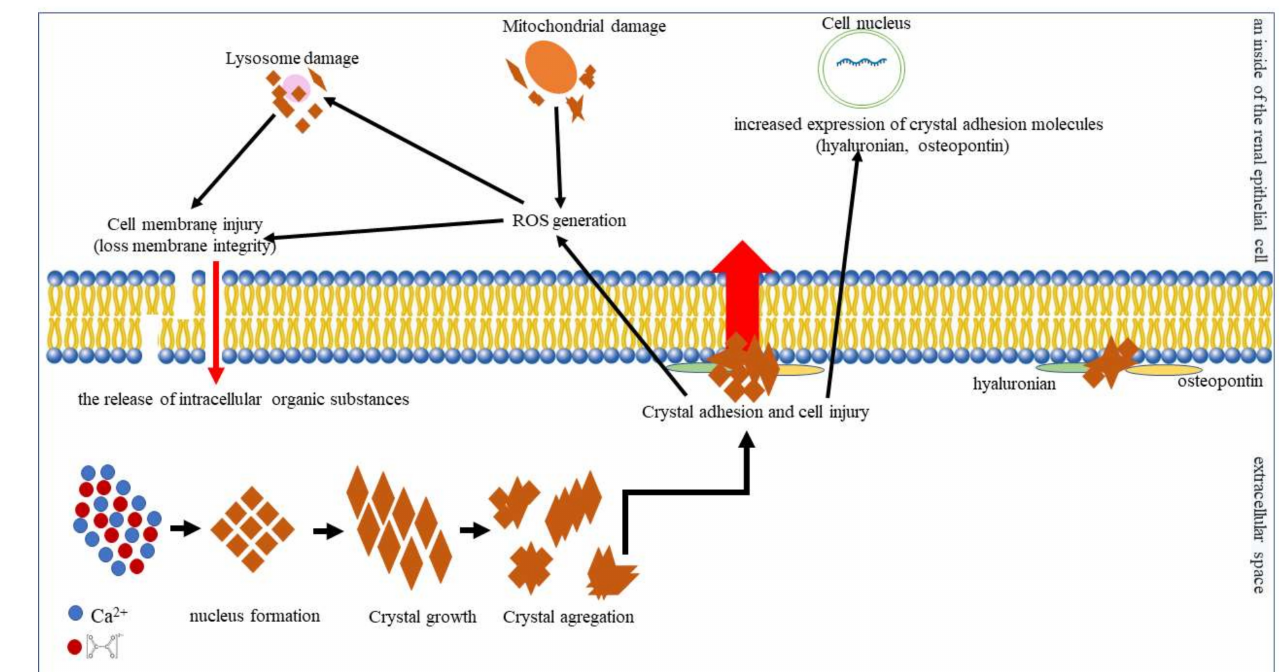
Figure 1. In supersaturated urine, calcium and oxalate combine to form initially microscopic in- soluble crystals. This is the first stage of deposit formation (nucleus formation). Then, individual microcrystals combine into larger forms (crystal growth), which, in turn, can aggregate together to form large, stable deposits (crystal aggregation) [34,35]. In the next stage, the crystals interact with the cells of the renal tubular epithelium. Crystal–cell interaction causes the movement of crystals from the basolateral side of cells to the basal membrane [36]. Injured cells release substances such as the kidney fragment of prothrombin − 1 or other anionic proteins that induce crystal agglomeration [37]. Moreover, injured cells can invert their cell membrane, which is anionic to the urinary environment and acts as a place of crystal adhesion. The inverted cell membrane makes it easy for other crystals to attach [38]. Exposure to calcium oxalate crystals induces oxidative stress in renal epithelial cells. In addition, calcium oxalate influences the composition and function of the renal epithelial cell membrane. Calcium oxalate crystals destroy tight junctions and the polarity of the cell membrane that carries the components of the basolateral or tight junction region to the apical surface of the cell, which, in turn, leads to rupture of the cell membrane and the release of intracellular organic substances. Damaged tubular epithelial cells also show increased expression of crystal adhesion molecules such as hyaluronan, osteopontin, and CD44, which promote crystal adhesion and retention. Endocytosed crystals adversely affect mitochondrial function, causing abnormality in the respiratory chain and increasing the mitochondrial production of reactive oxygen species (ROS), which may damage, and induce apoptosis of, renal epithelial cells